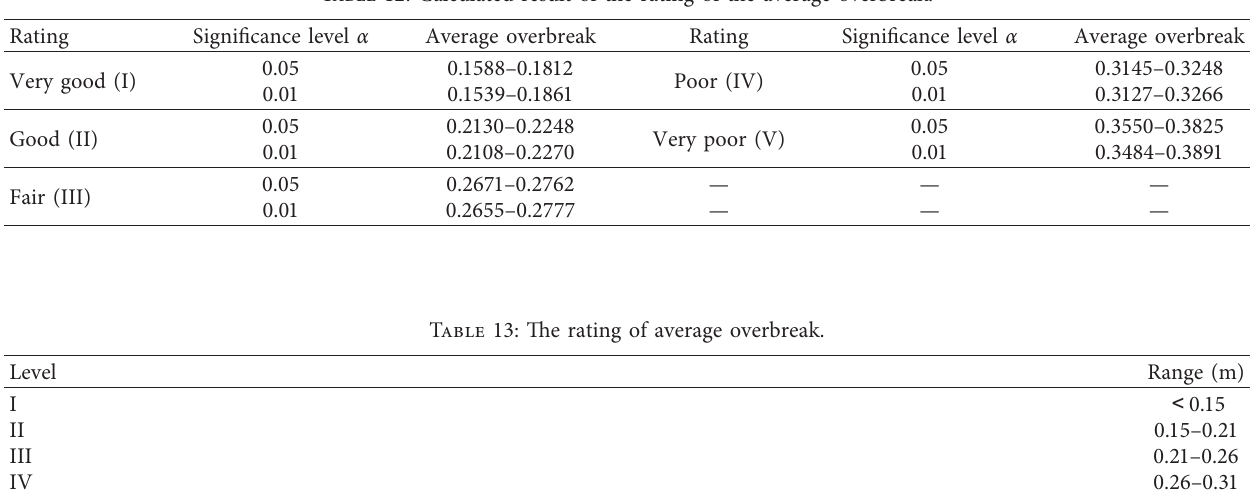
Table 12: Calculated result of the rating of the average